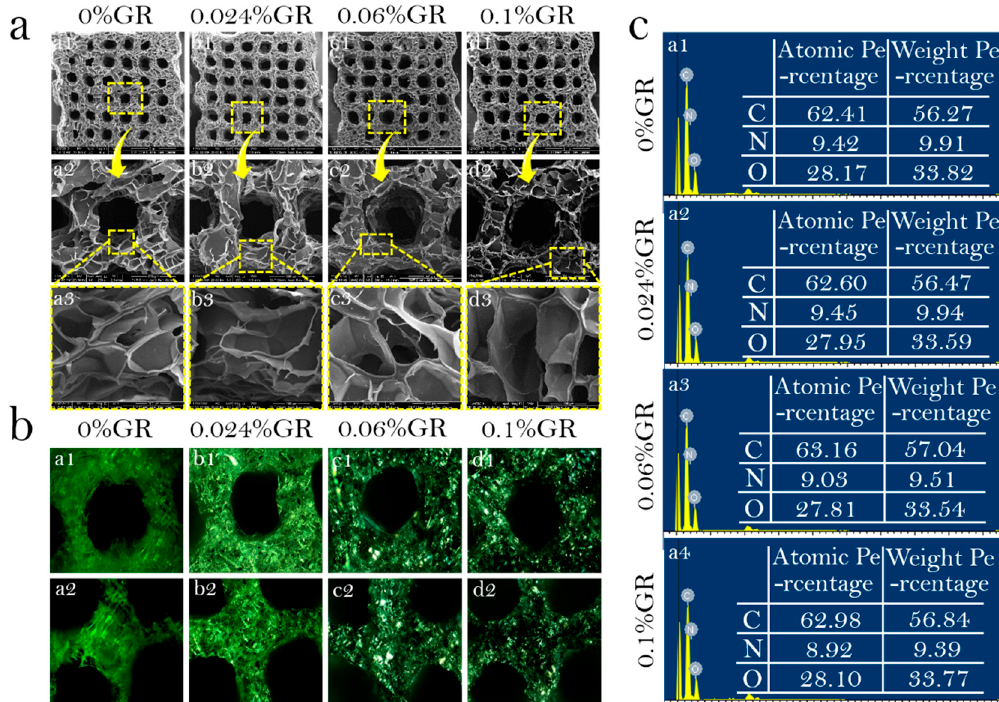
Figure 5. Physical and chemical properties of bio-scaffolds. ( a ): SEM of bio-scaffolds; (a 1 –a 3 ) 0%GR scaffold, (b 1 –b 3 ) 0.024%GR scaffold, (c 1 –c 3 ) 0.06%GR scaffold, (d 1 –d 3 ) 0.1%GR scaffold, (a 1 –d 1 ) 50×, (a 2 –d 2 ) 200×, (a3–d3) 800×; ( b ): Polarized microscope of bio-scaffolds. (a 1 –a 2 ) 0%GR scaffold, (b 1 –b 2 ) 0.024%GR scaffold, (c 1 ,c 2 ) 0.06%GR scaffold, (d 1 ,d 2 ) 0.1%GR scaffold; ( c ): EDS of bio-scaffolds. (a 1 ) 0%GR scaffold, (a 2 ) 0.024%GR scaffold, (a 3 ) 0.06%GR scaffold, (a 4 ) 0.1%GR scaffold.